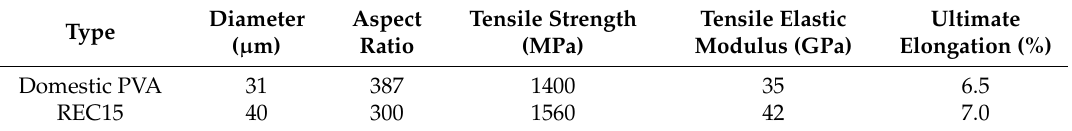
Table 3. Performance indexes of PVA